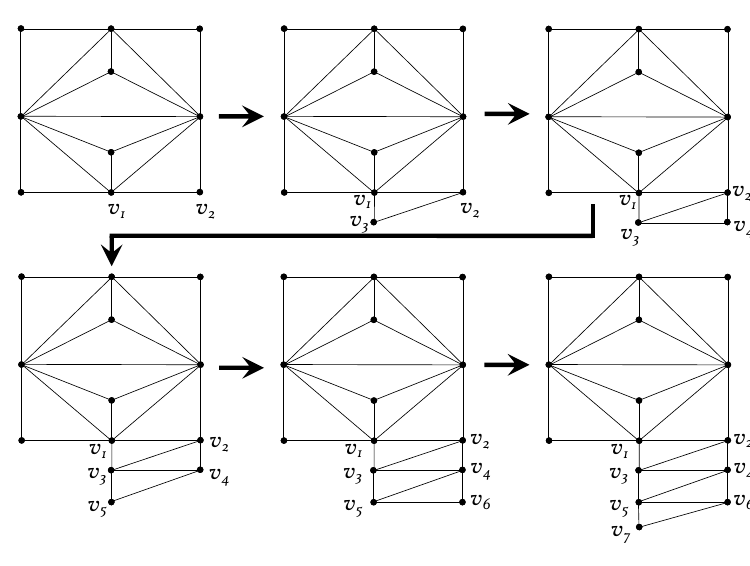
Fig. 7: Constructing nontraceable LT graphs with ∆( G ) = 7